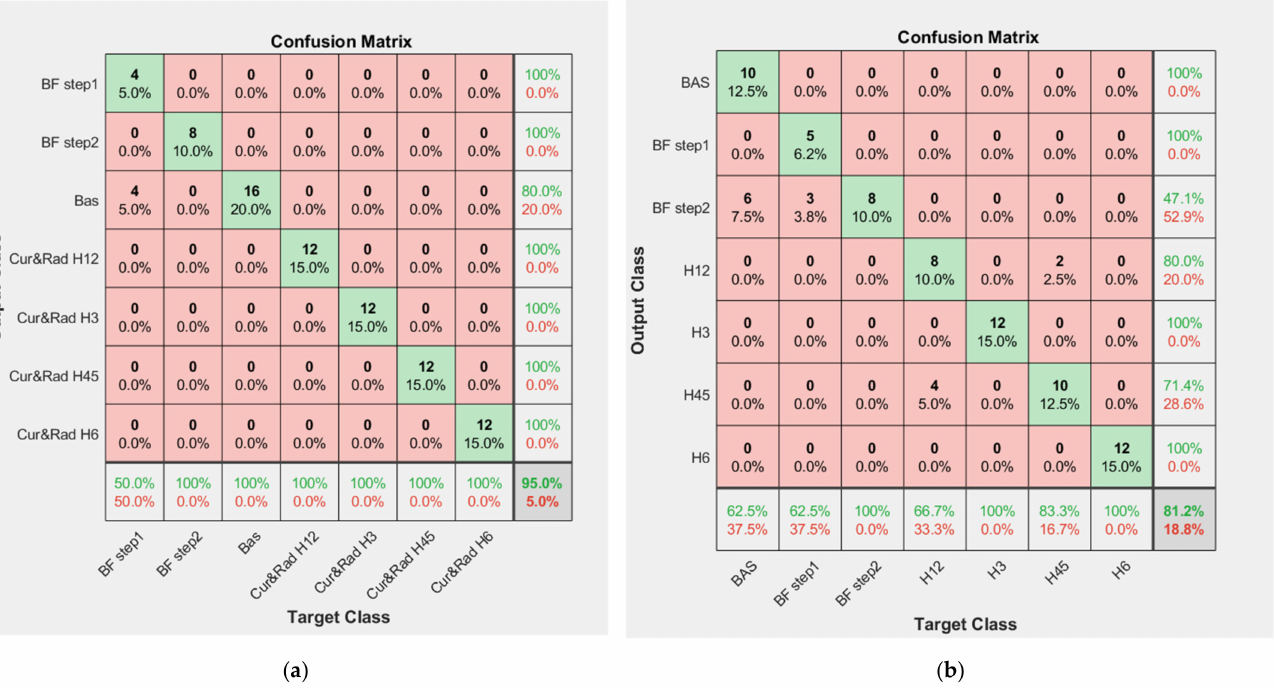
Figure 14. Confusion matrix (test set) for the mixed-signals approach of ( a ) non-decimated data and ( b ) decimated